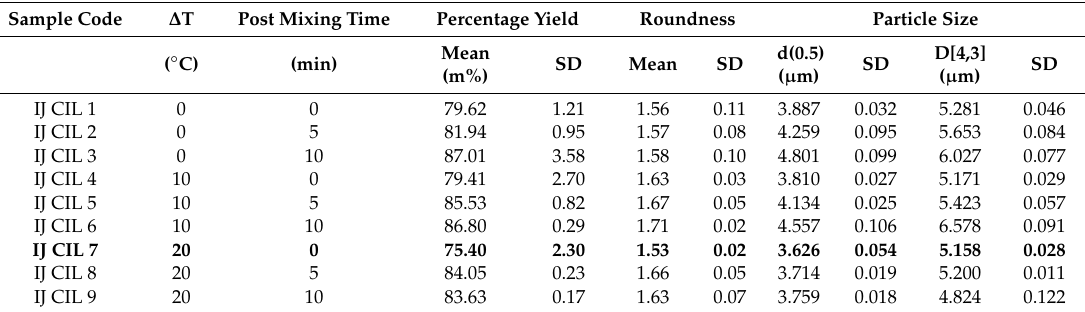
Table 2. Crystallization results of impinging jet